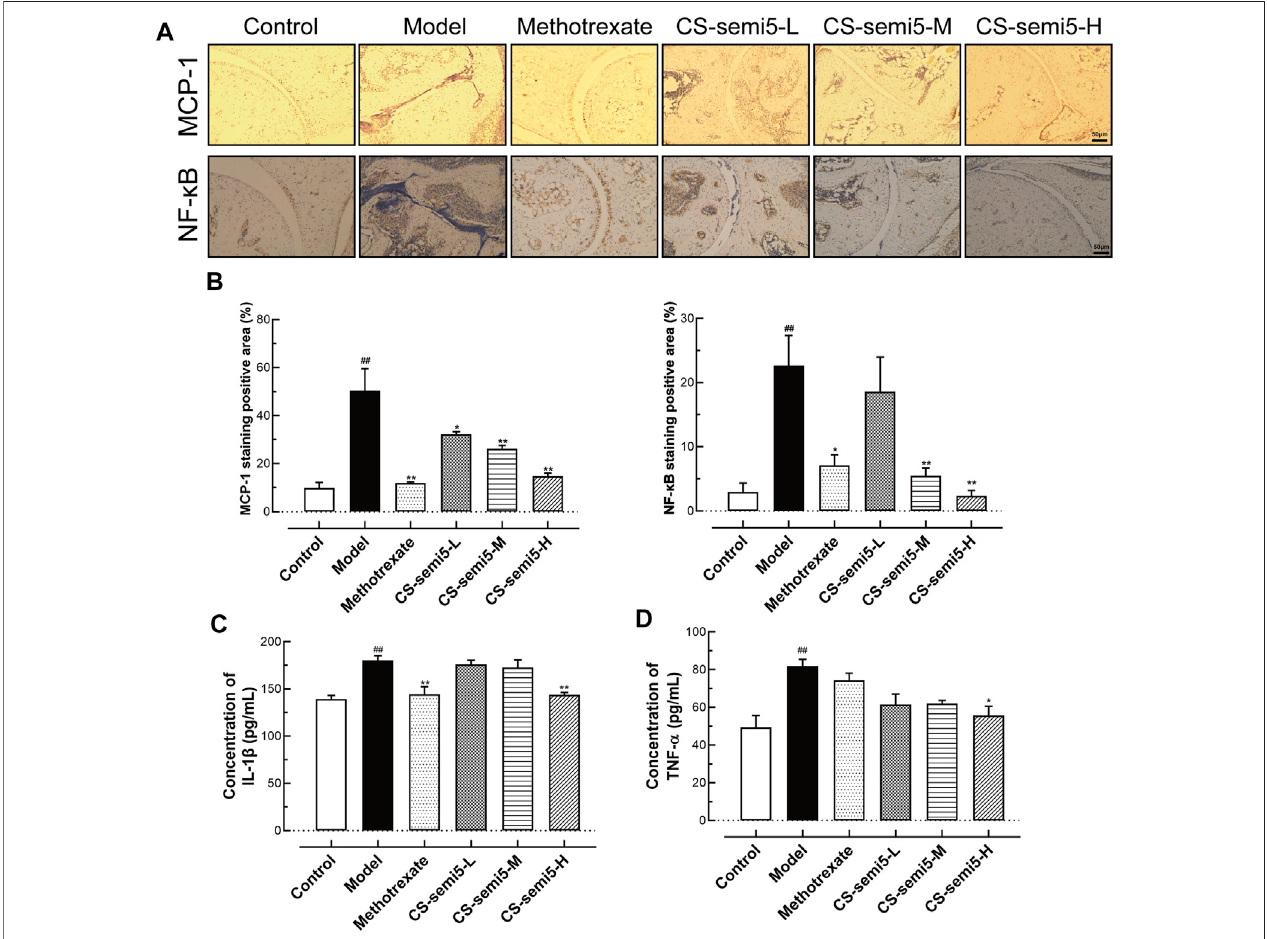
FIGURE 5 | CS-semi5 attenuates CIA-induced arthritis in vivo. (A) Histologic sections of ankle joints following immunostaining with MCP-1 and NF- κ B antibodies (40 × magni fi cation). (B) Positivestainingwasmeasuredbydigitalquanti fi cation. (C,D) SerumIL-1 β andTNF- α wereassessedbyELISA. n (cid:1) 7. ## p < 0.01comparedwith Control group; * p < 0.05 and ** p < 0.01 compared with Model